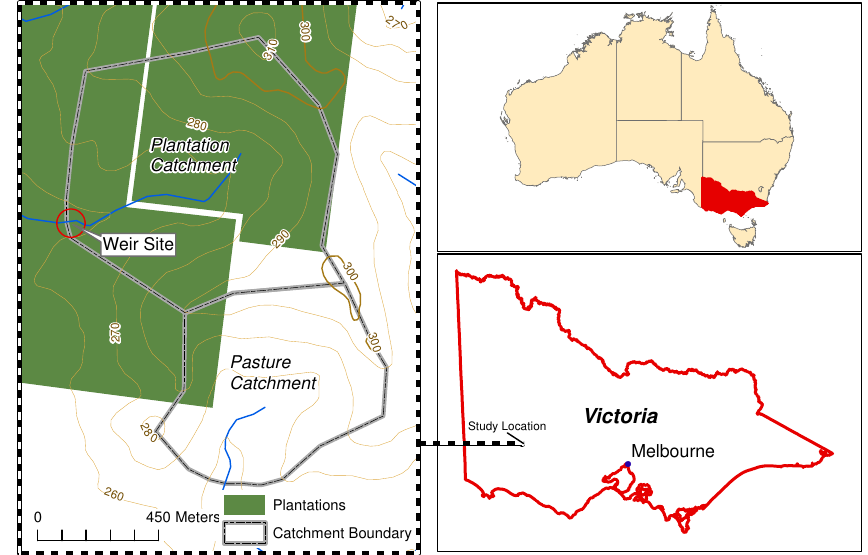
Fig. 1. Weir site